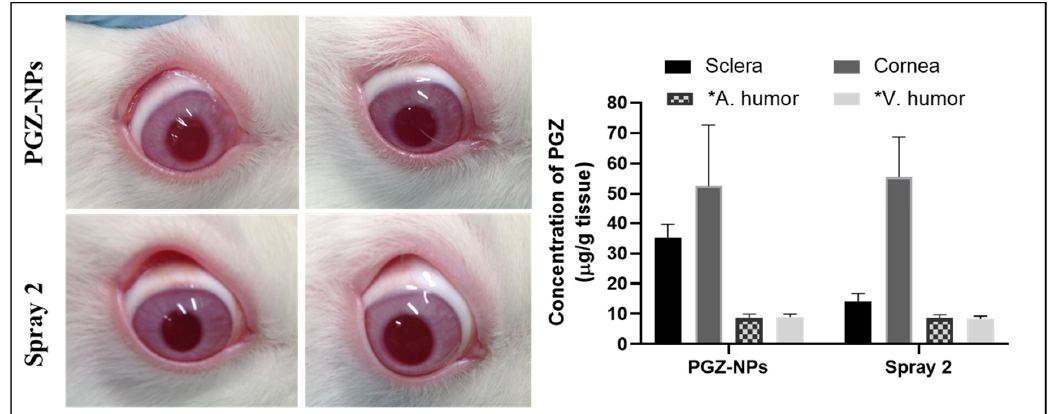
Figure 7. Bioavailability study. Levels of PGZ after 10 d of administration of PGZ ‐ NPs and the Spray 2 formulation. * Vitreous Humor and Aqueous Humor: data are expressed as μ g/mL. The values are expressed by mean ± SD ( n = 3).